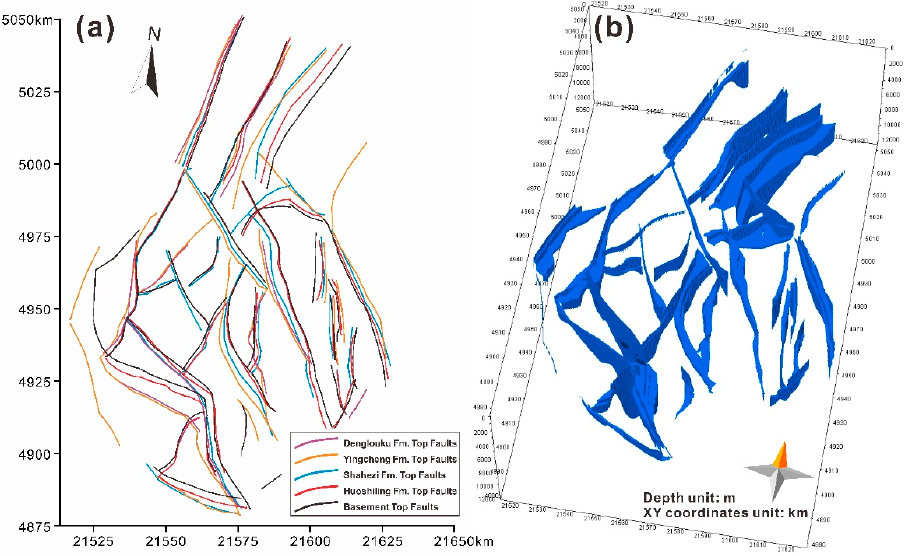
Figure 7. Fault distribution in the Changling Depression. ( a ) Fault intersections on each layer surface. ( b ) Distribution of the gridded faults of the Changling Depression in the model.